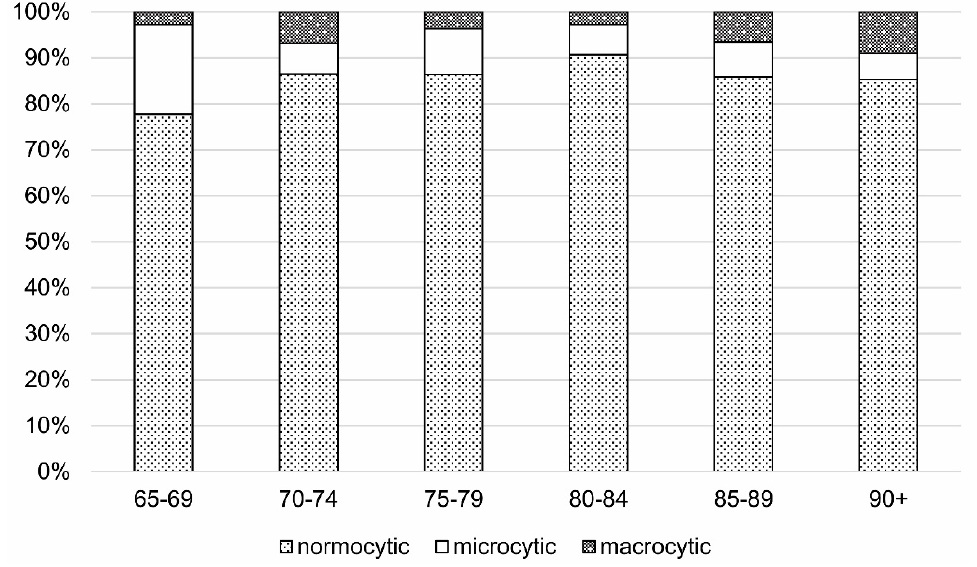
Figure 1. The percentage rate of normocytic, microcytic, and macrocytic anemia in age cohorts in the PolSenior study.